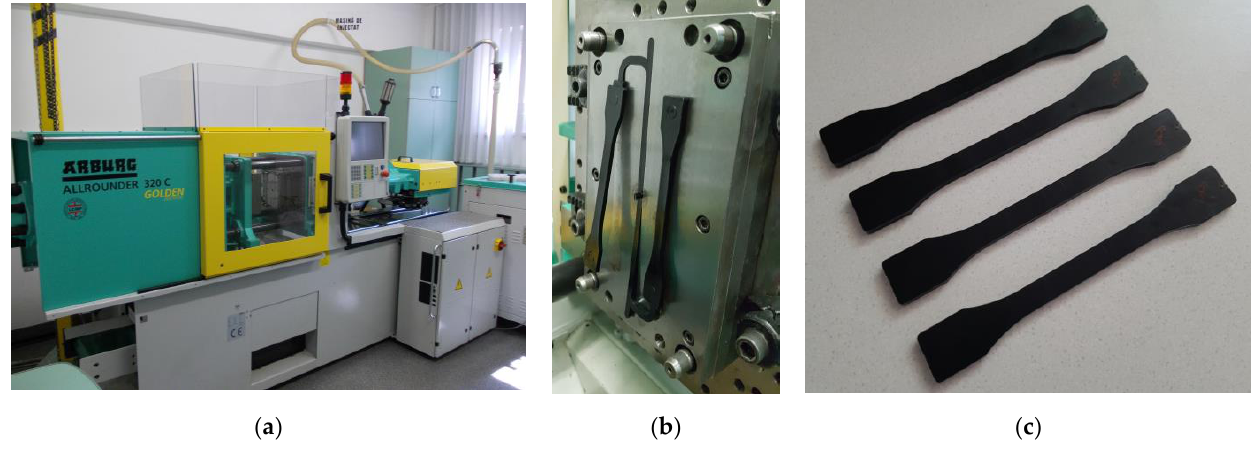
Figure 2. Injection molding process: ( a ) injection molding machine, ( b ) two-cavity mold, and ( c ) injection-molded tensile specimens.